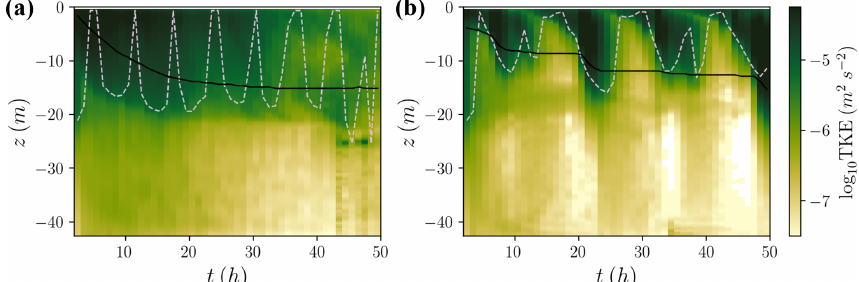
Figure 7. Horizontally averaged turbulence characteristics for (a) 0.15 ◦ C thermal driving and 0.01 ◦ slope case and (b) 0.6 ◦ C thermal driving and 1 ◦ slope case. Turbulence is considered intermittent when the dissipation contour of 10 − 9 m 2 s − 3 (dashed line) reaches the boundary. Significant turbulence kinetic energy (TKE, green-yellow shading) can be present when dissipation is low. Higher TKE at − 25m at later times in (a) is due to turbulent transport, while the higher TKE at later times in (b) is due to shear production. IOBL depth is contoured in